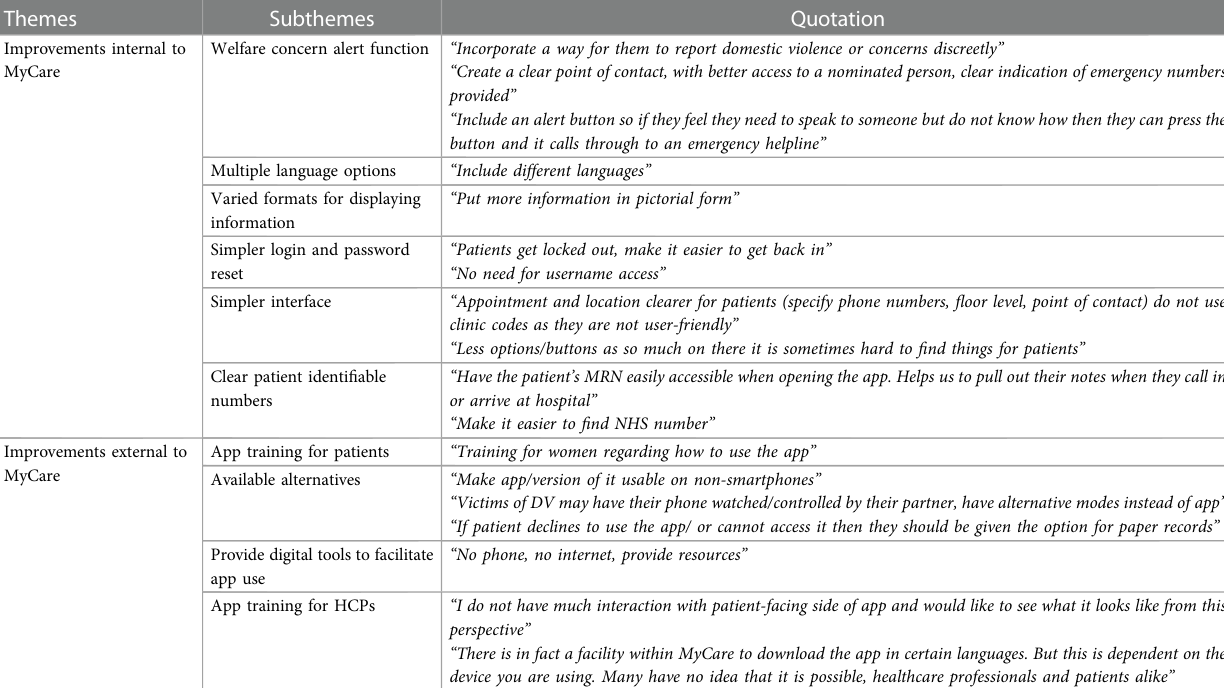
TABLE 4 Table showing the themes, subthemes, and selected quotations that represent participants ’ suggestions for MyCare